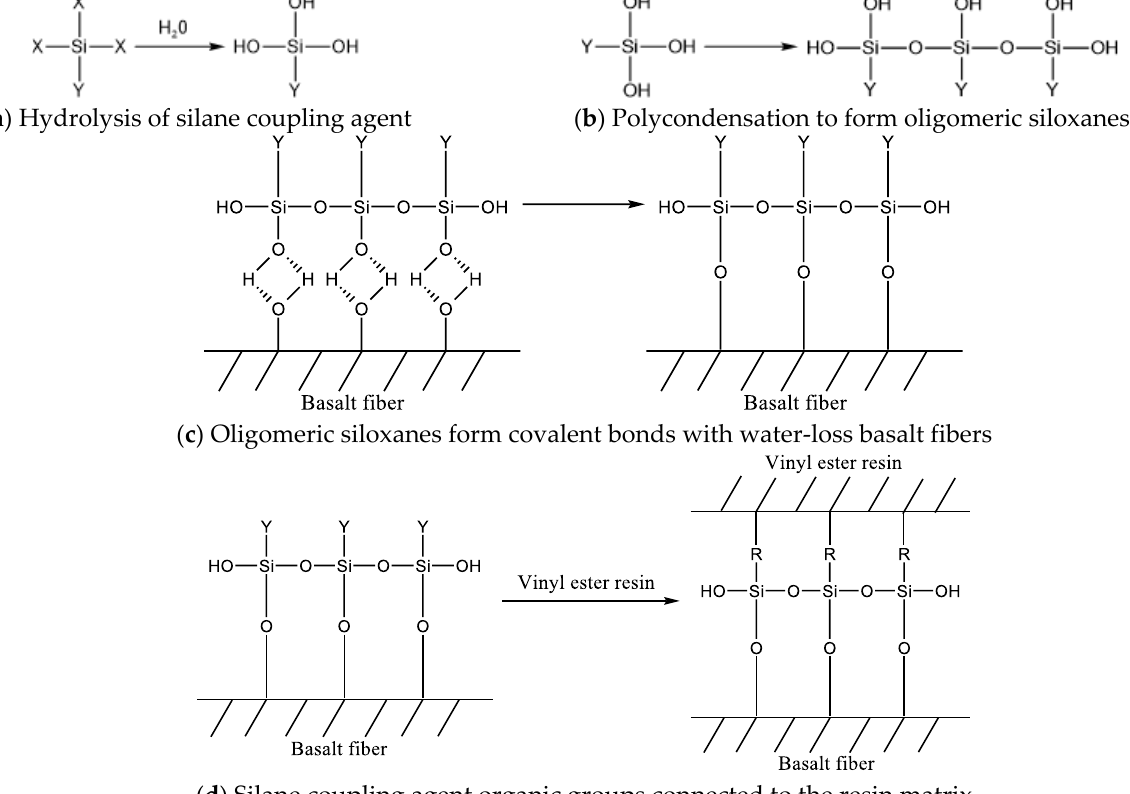
Figure 6. Mechanism of action of a silane-coupling-agent-modified